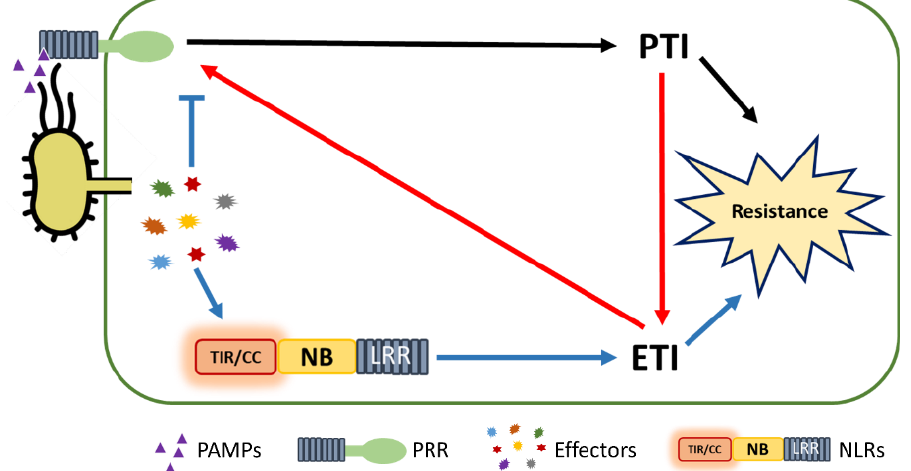
Figure 3. The integration of pattern-triggered immunity (PTI) and effector-triggered immunity (ETI) in plant immunity. In response to pathogens, an induced defense response is turned on by pattern recognition receptors (PRRs)-mediated PTI (indicated by black arrows) and nucleotide-binding and leucine-rich-repeat-containing receptors (NLRs)-mediated ETI (indicated by blue arrows). Recent reports indicate that there is substantial crosstalk between PTI and ETI (indicated by red arrows). ETI functions through PTI components and potentiates PTI signaling. Synergistically, PTI also enhances the ETI response. The cooperation of PTI and ETI mutually contributes to plant innate immunity.